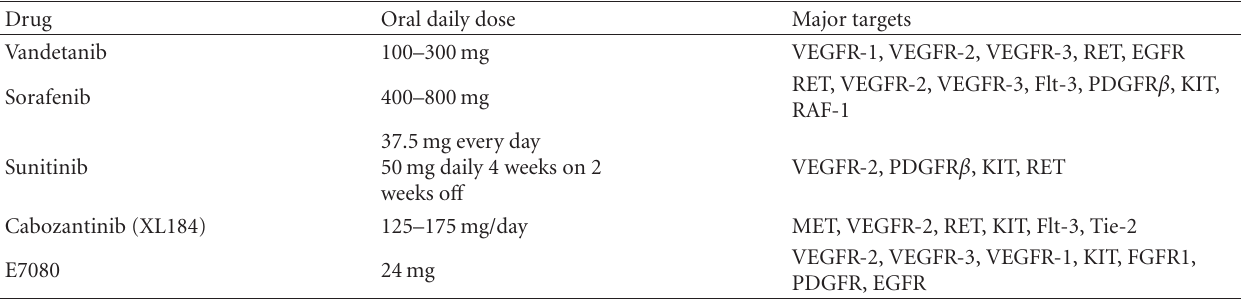
Table 1: Some of the TKIs currently used for the treatment of MTC in clinical trials and o ff